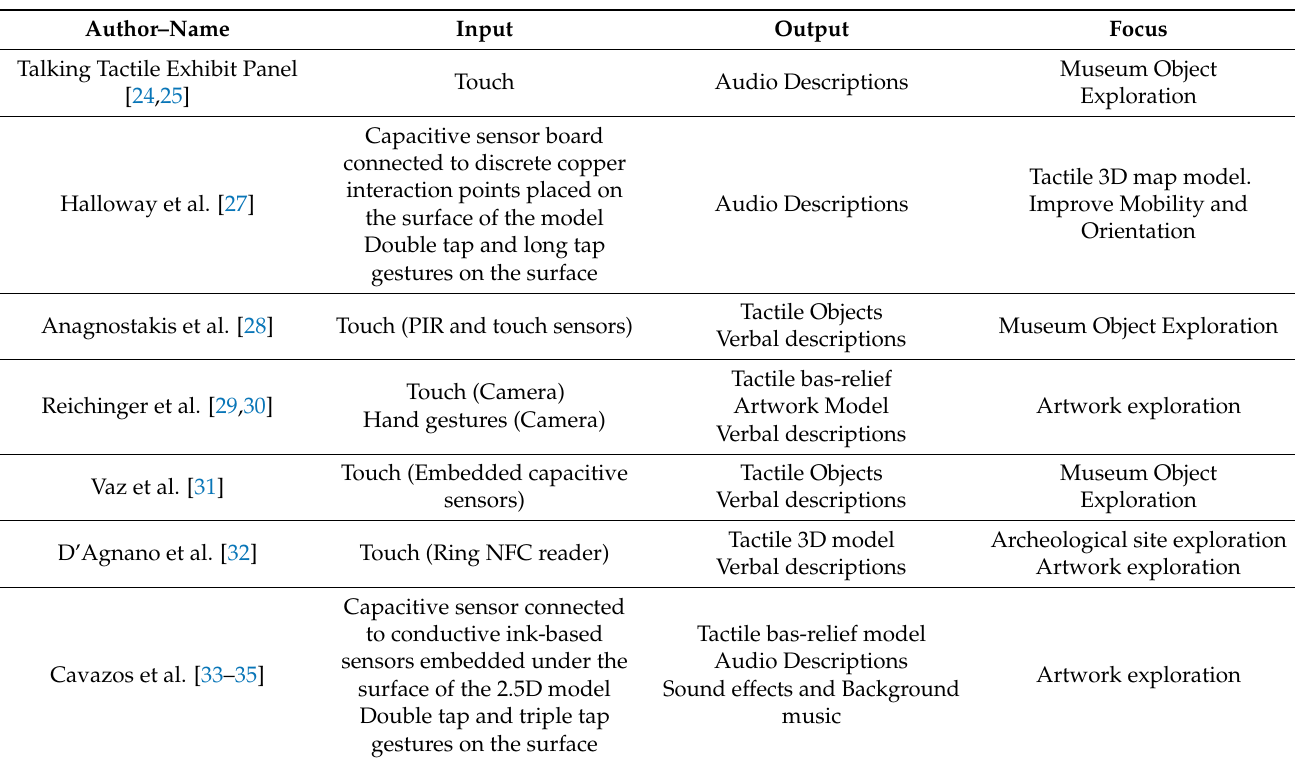
Table 2. Interactive multimodal guide for appreciating visual artwork and museum